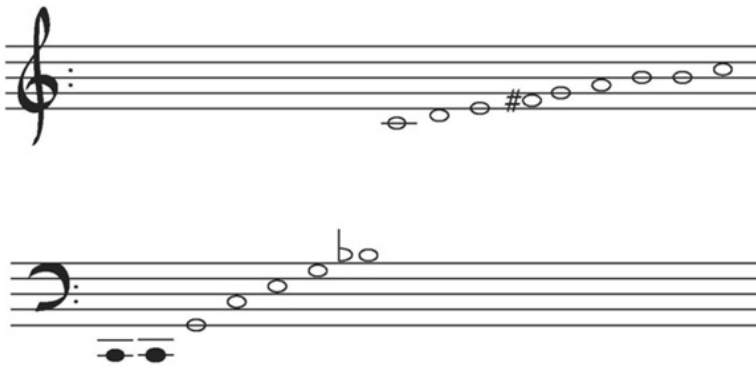
FIGURE 2. The number of overtones (nodes give only an approximate